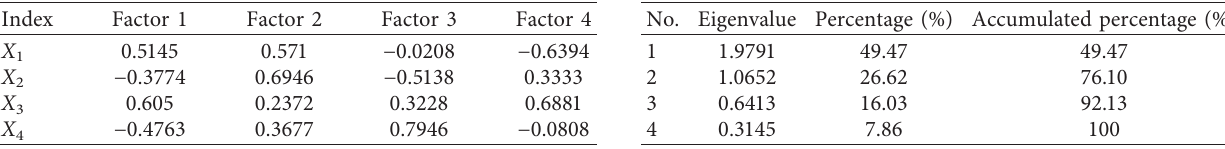
Table 5: Eigenvectors of point indices. Table 6: Eigenvalues of point